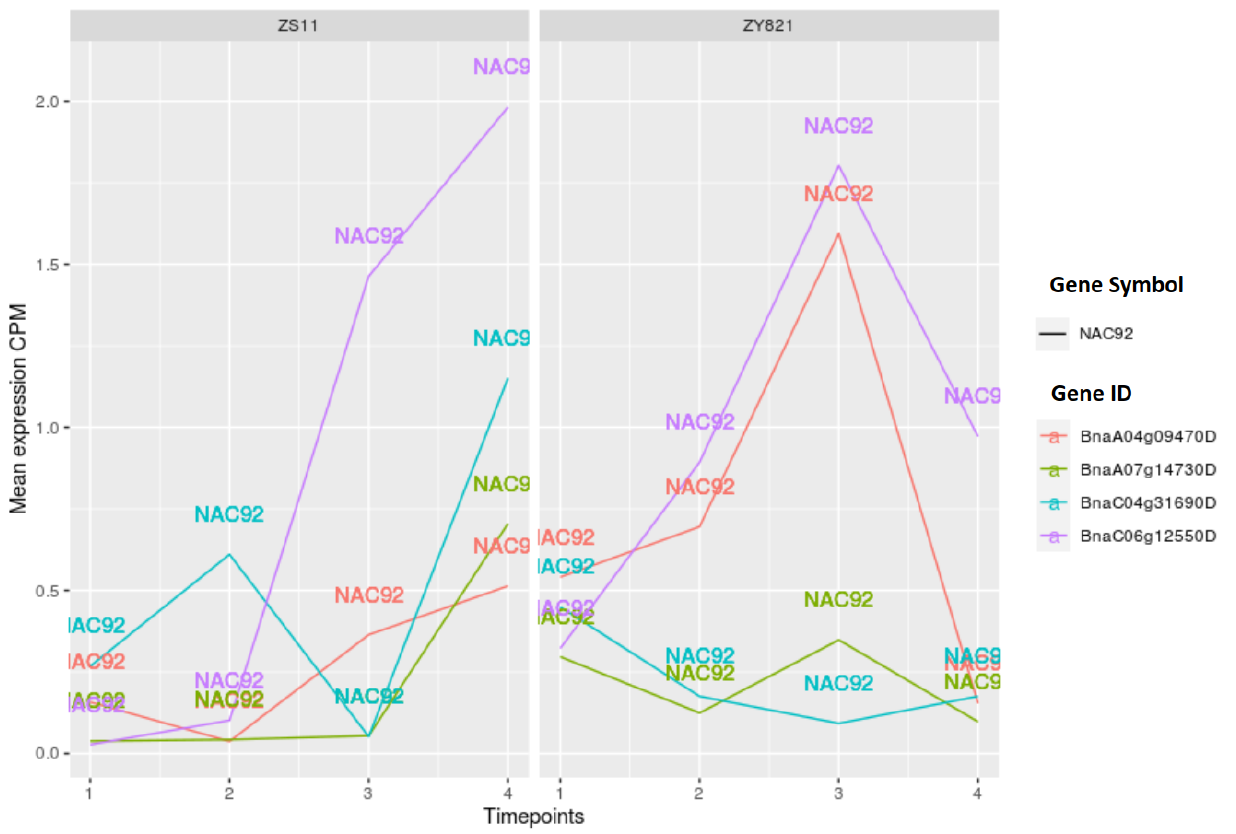
Figure 4. Expression values of NAC92 orthologous genes. Time points 1 to 4 represents day 7, day 10, day 15, and day 45 after